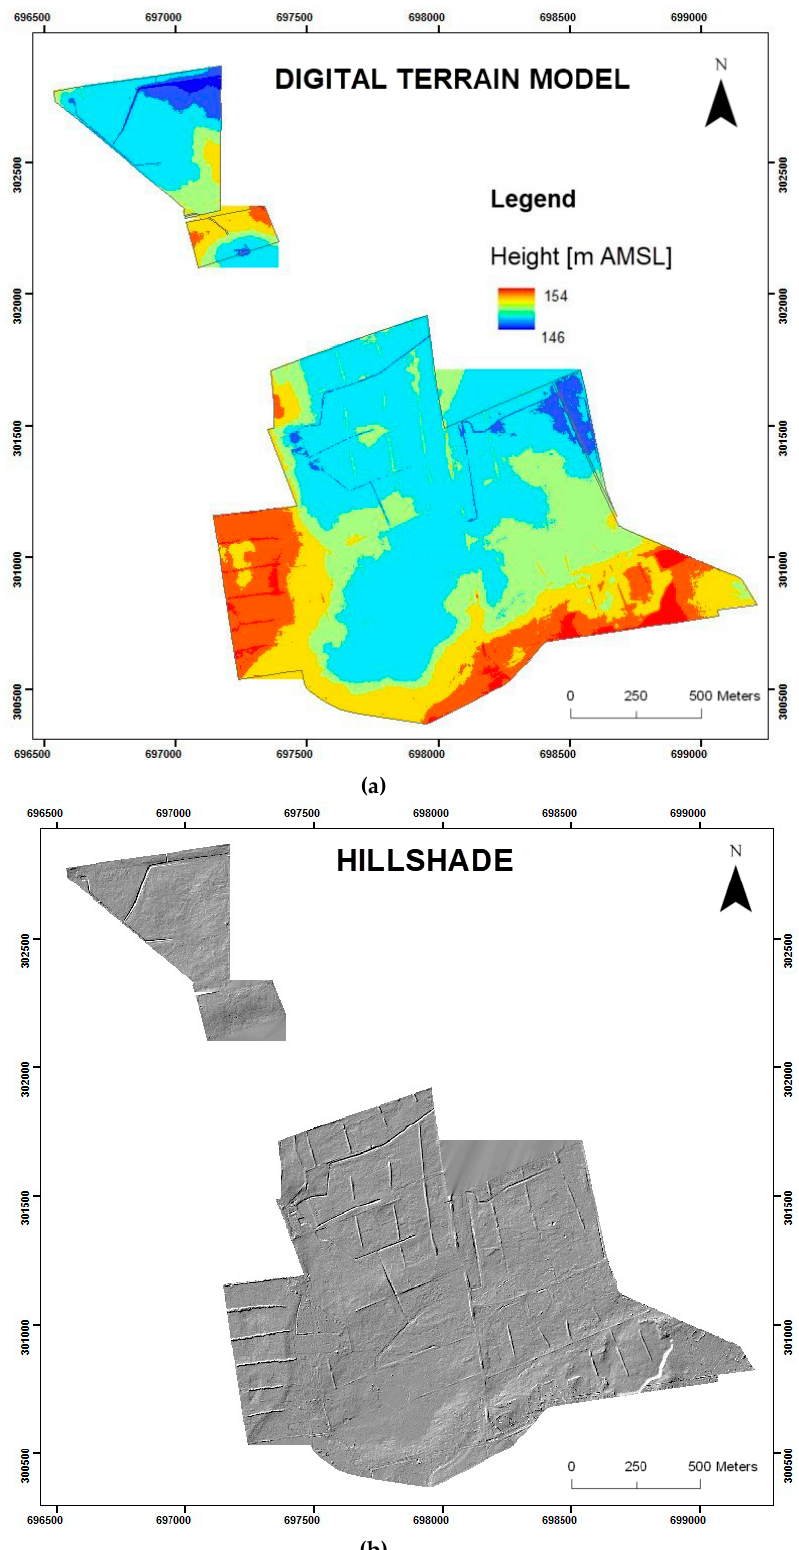
Figure 7. The former sulfur mine Jeziórko research area: ( a ) DTM and ( b ) hillshade.